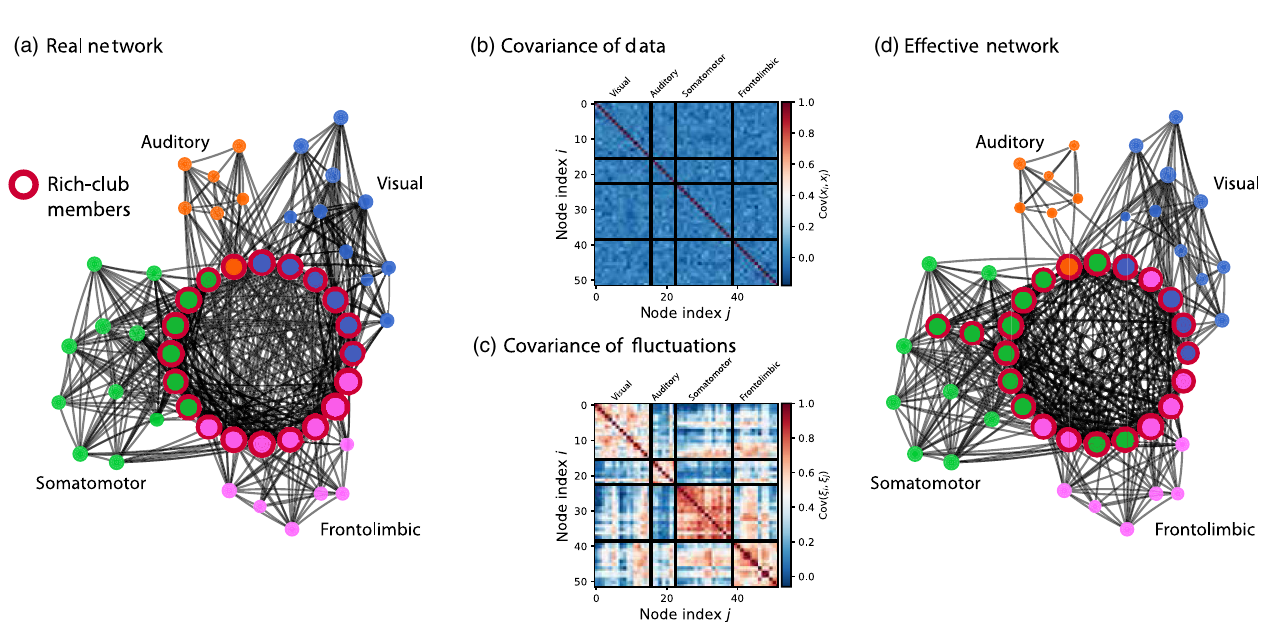
FIG. 1. Effective network of the cat cerebral cortex. We use the local dynamics as a spiking neuron coupled via electric synapses. (a) The cat cerebral cortex network with nodes color coded according to the four functional modules. Rich-club members are indicated by red encircled nodes. (b) The covariance matrix of the data cannot detect communities. (c) The covariance matrix of the fluctuations can distinguish clusters. This matrix has entries color coded (according to the key on the right) with red entries corresponding to pairs of nodes sharing a large numbers of nearest neighbors in the network, while blue nodes correspond to pairs of nodes that share a small number of common neighbors. (d) A model in the cat cortex constructed via the effective network approach. From the matrix in (c) we can recover a representative effective network. The reconstructed network represents the actual network in (a) with good